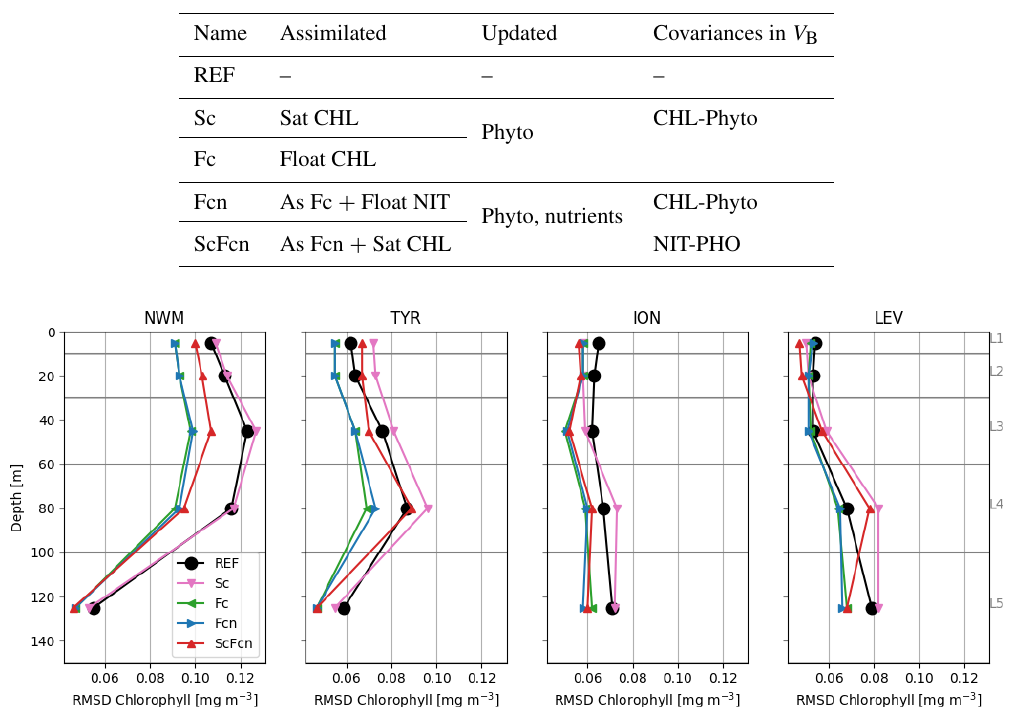
Figure 2. RMSD between model simulations and BGC-Argo chlorophyll values in four sub-basins (Fig. 1). Grey lines indicate the limits of layers L1–L5 (Table 2) used to calculate the chlorophyll RMSD.